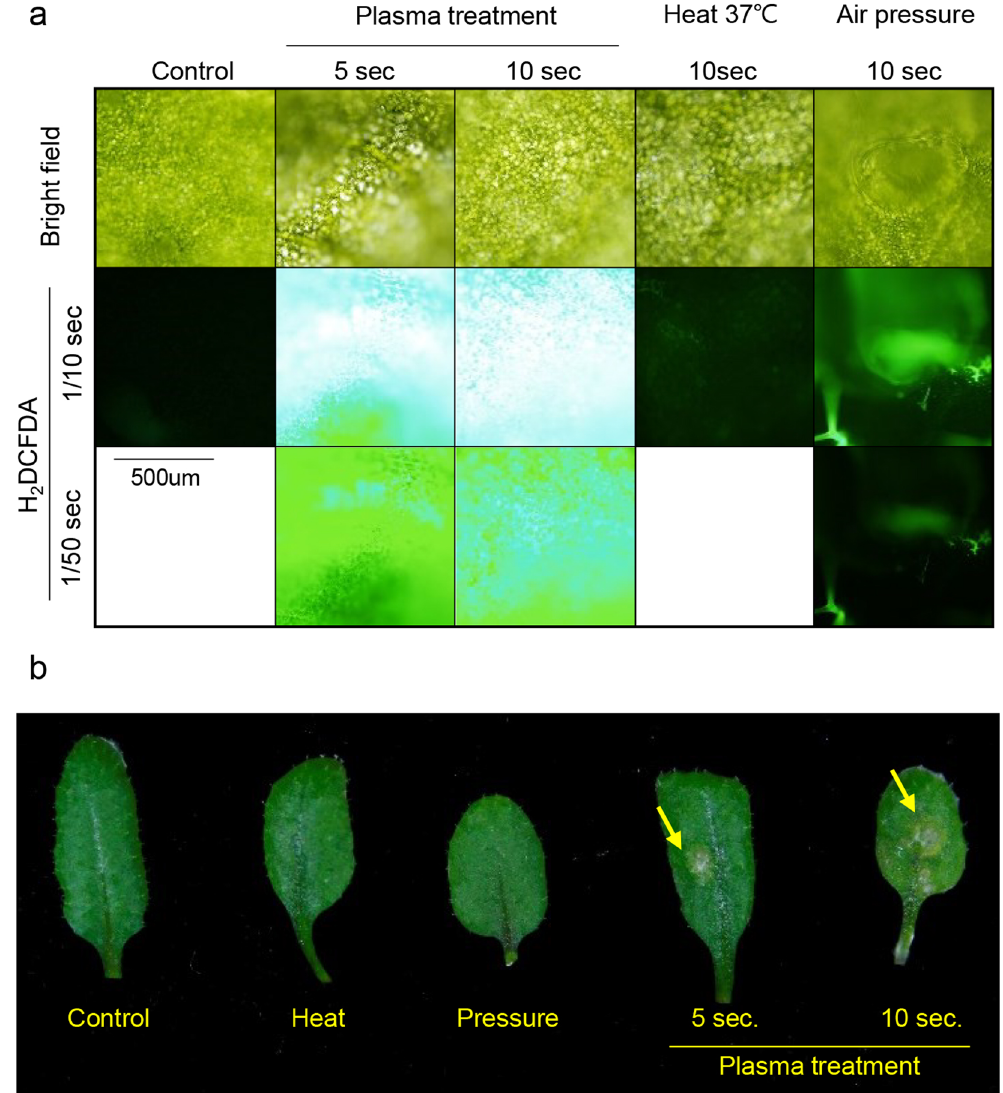
Figure 6. Adult leaf treated with plasma. ( a ) DCFDA fluorescence image of adult leaf in treated area. Upper panel indicates treatments. Times indicated under H 2 DCFDA is exposure time (seconds). Scale bar = 500 um. Representative image were determined from 5 experiments for each conditions. ( b ) Phenotype of adult leaf after plasma treatment in long day condition for 3 days. Yellow arrow indicates plasma treated area. Heat and Pressure indicates 37 °C heat for 10 seconds and air pressure for 10 seconds,